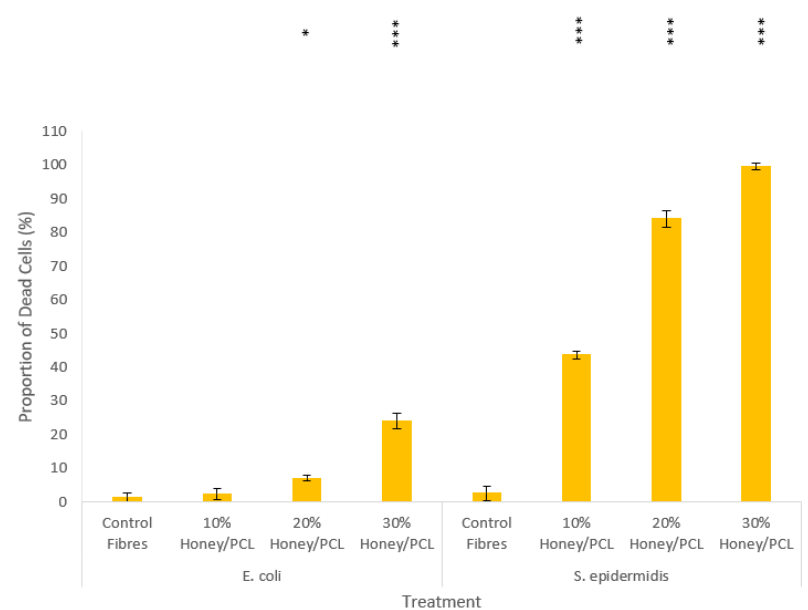
Figure 7. Antibacterial activity of 10, 20 and 30% manuka-PCL composite fibrous meshes compared to the negative control of virgin PCL fibres; antibacterial effectiveness is expressed as the percentage bacterial reduction. The post hoc Tukey HSD results of the treatments compared to the control are shown on the graph as p values of < 0.05 (*) and <0.001